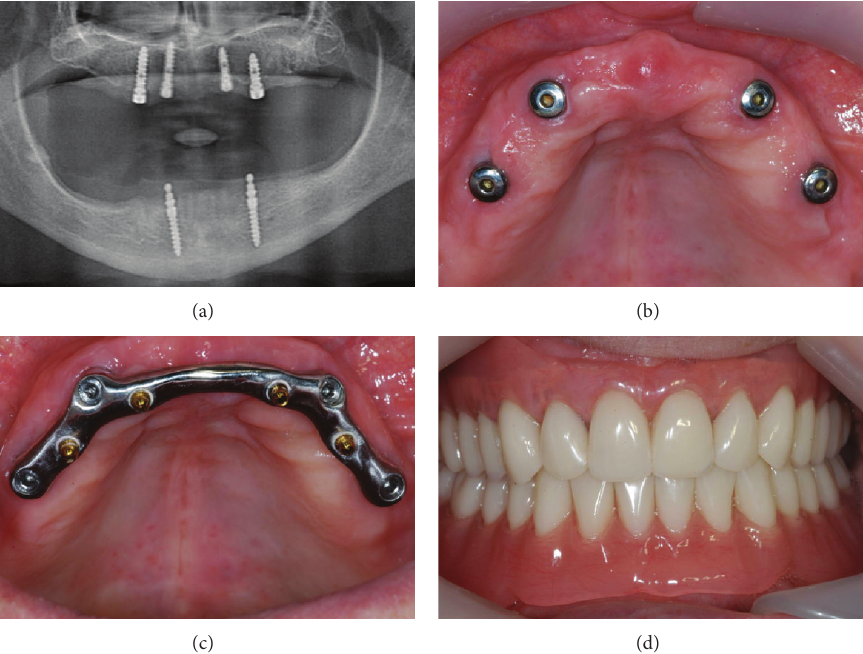
Figure 3: Surgical and prosthetic procedures: panoramic radiograph at implant placement (a); the implants after 4 months of undisturbed healing (b); the maxillary bar after application (c); clinical view of the maxillary overdenture (OD) at delivery (d).